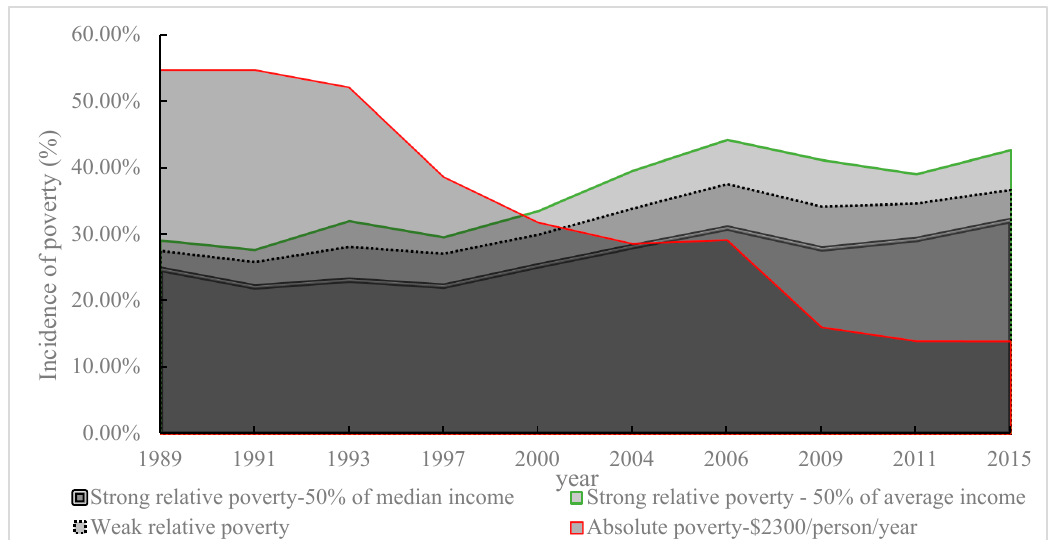
Figure 2. Incidence of absolute poverty and weakly relative poverty in China from 1989 to 2015.